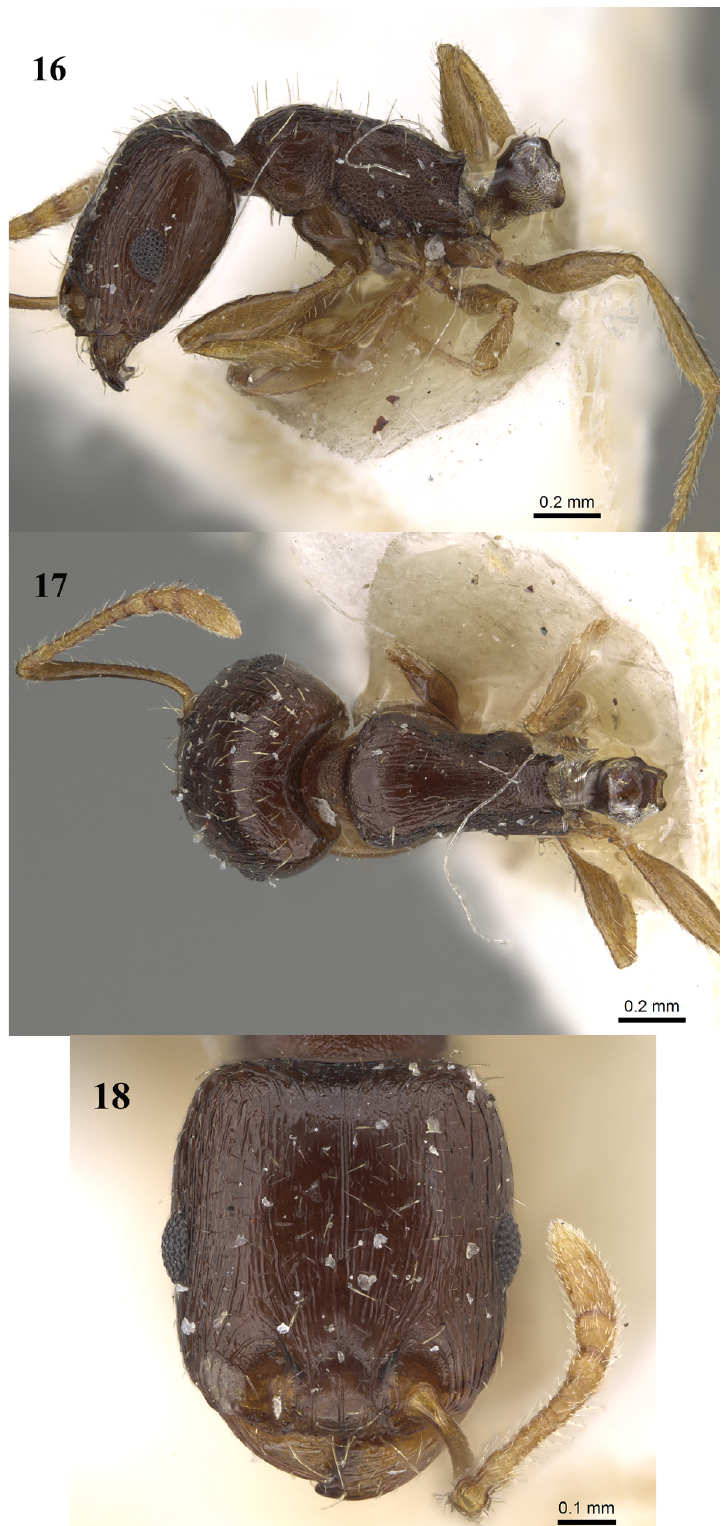
Figs 16–18 . Tetramorium saudiae (Collingwood & Agosti, 1996), holotype, worker (CASENT0922184). 16 . Body in profile. 17 . Body in dorsal view. 18 . Head in frontal